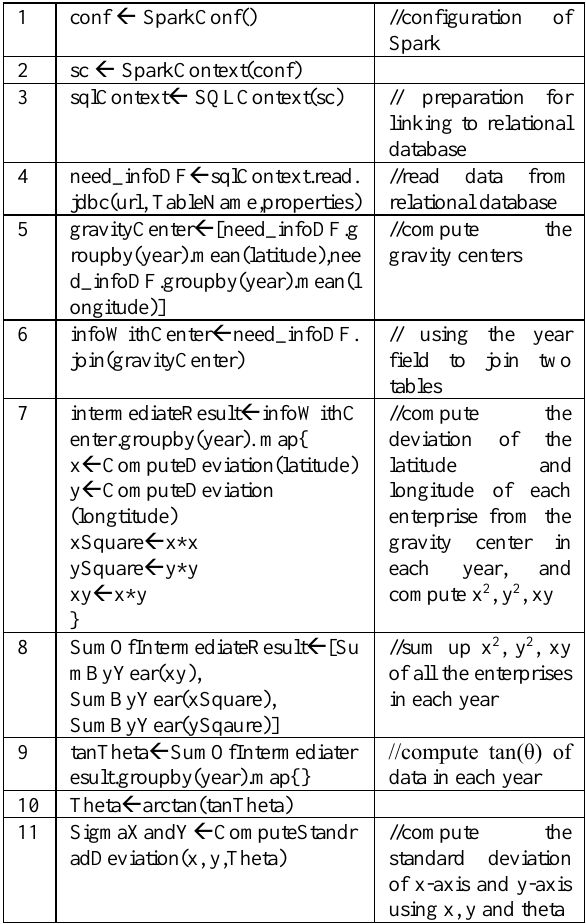
Table 3. Pseudocode of the computation of SDE and gravity